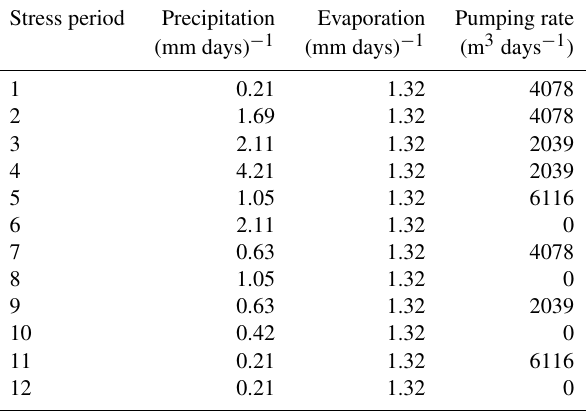
Table 2. The precipitation, evaporation, and pumping rates in 12 stress periods. Stress